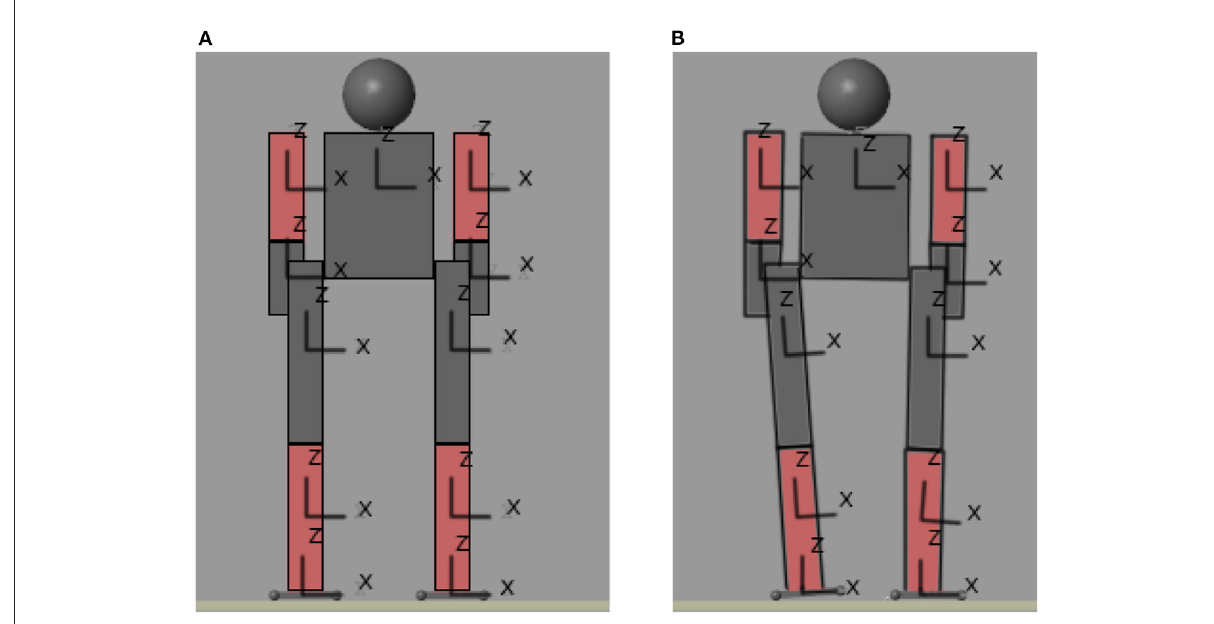
FIGURE3 Movement of the biped. (A) Initial position. (B) First stable position.